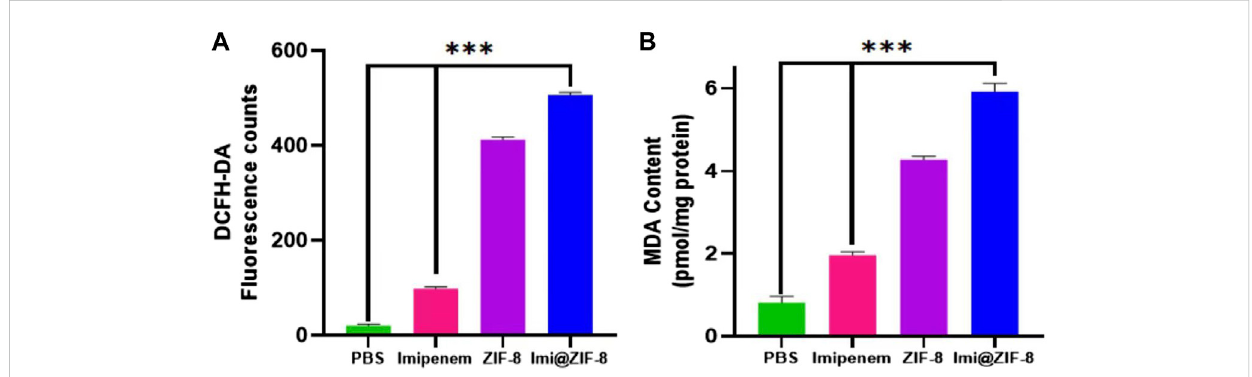
FIGURE 5 Antibacterial mechanism of Imi@ZIF-8. (A) The fl uorescence intensity of A. baumannii was measured using a fl uorometer to re fl ect ROS formation. (B) MDA contents of A. baumannii treated with respective materials (PBS, imipenem, ZIF-8 or Imi@ZIF-8) for 24 h represents the extent of membrane damage. Data are presented as mean ± SD ( n = 3). Compared to the PBS group and the imipenem group: *** p <